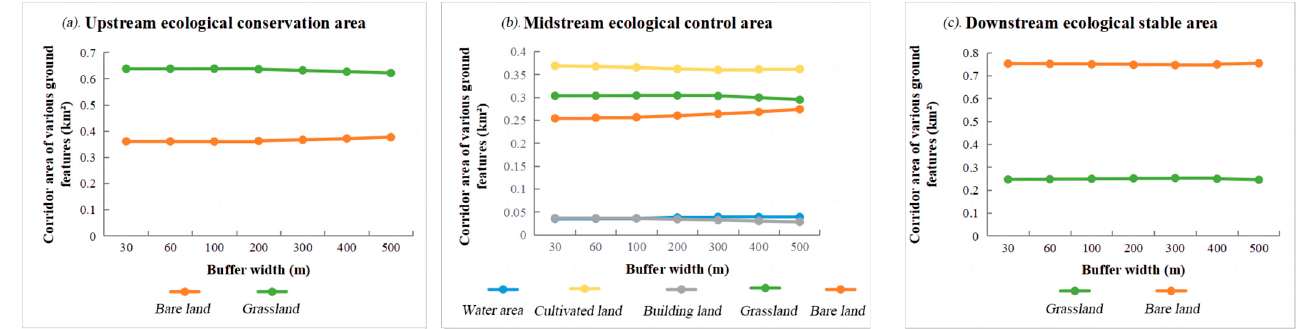
Figure 13. Optimum width of the corridor in each area.